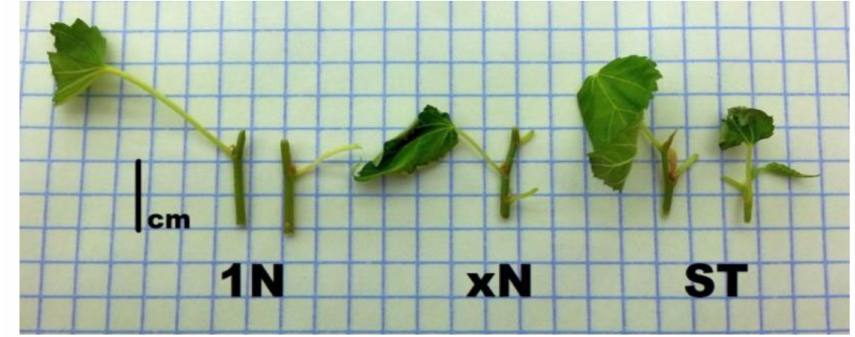
Figure 3. Types of explants used in experiments. 1N—single-node explants prepared from “SNC” cultures; xN—several node explant prepared from “AxB” cultures; ST—shoot-tip explants obtained from “AxB” or “SNC” cultures. The bar is 1 cm